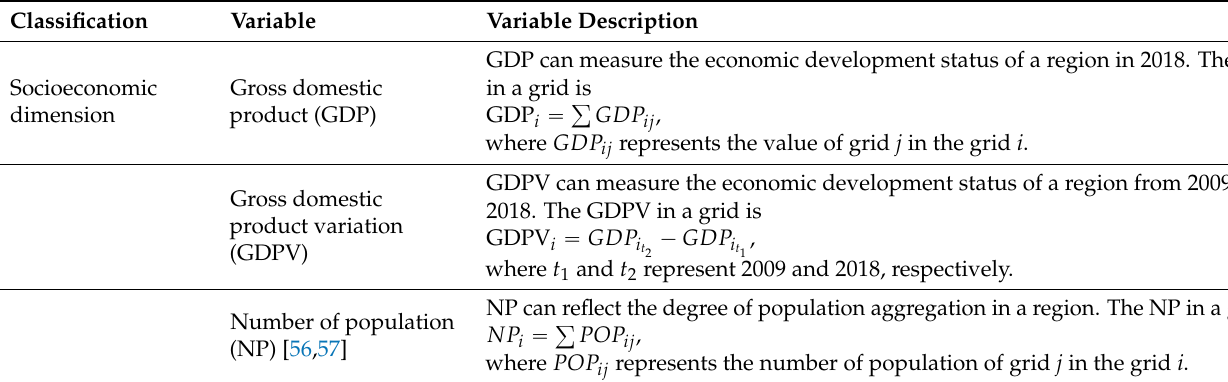
Table 2. Description and calculation of